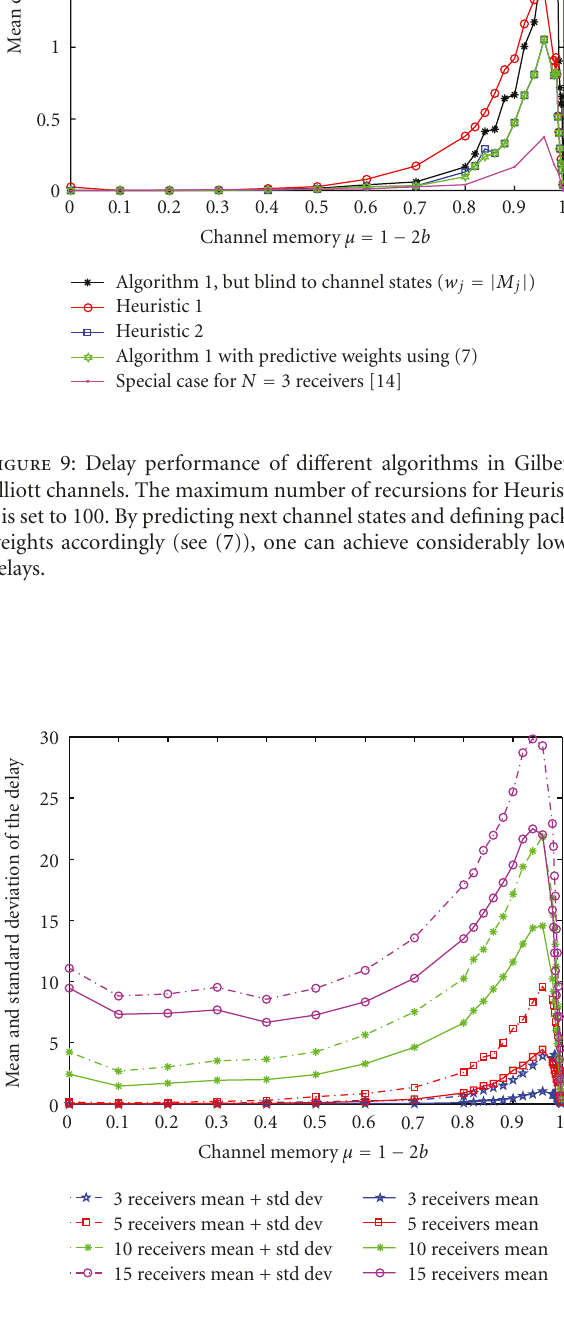
Figure 10: Delay performance of Algorithm 1 with weights defined using (7) for di ff erent number of receivers. As expected, the delay increases with the number of receivers. Both the mean delay (solid curves) and mean delay plus one standard deviation of delay (dashed-dotted curves) across 1000 stochastic runs of the transmission are shown.